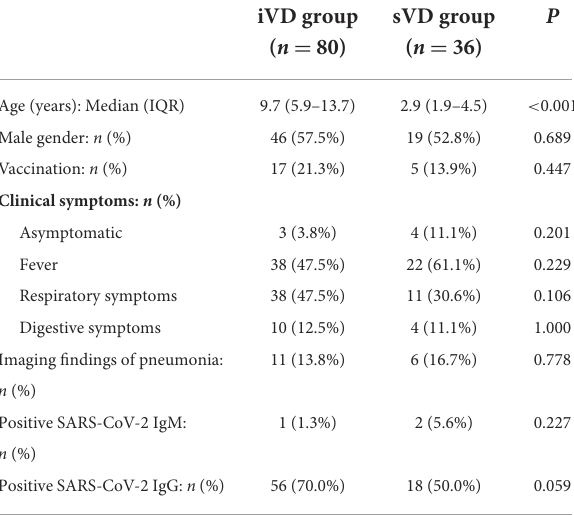
TABLE 2 Univariate comparison of clinical characteristics between the iVD and sVD groups.